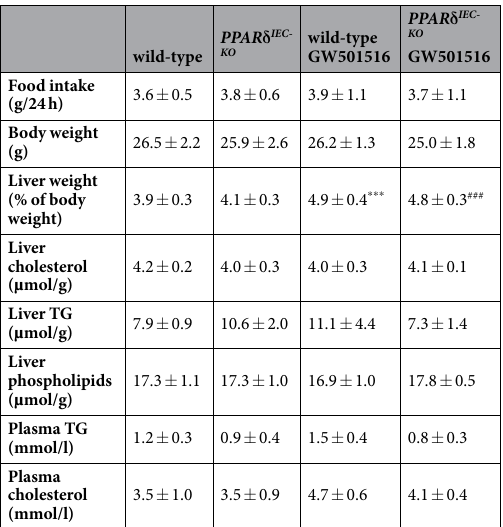
Table 1. Animal characteristics and liver composition of wild-type and PPAR δ IEC-KO mice with and without GW501516 treatment on low fat diet. *** Significantly different from wild-type (p < 0.001); ### Significantly different from PPAR δ IEC-KO (p < 0.001); Values are presented as means ± SD (n =